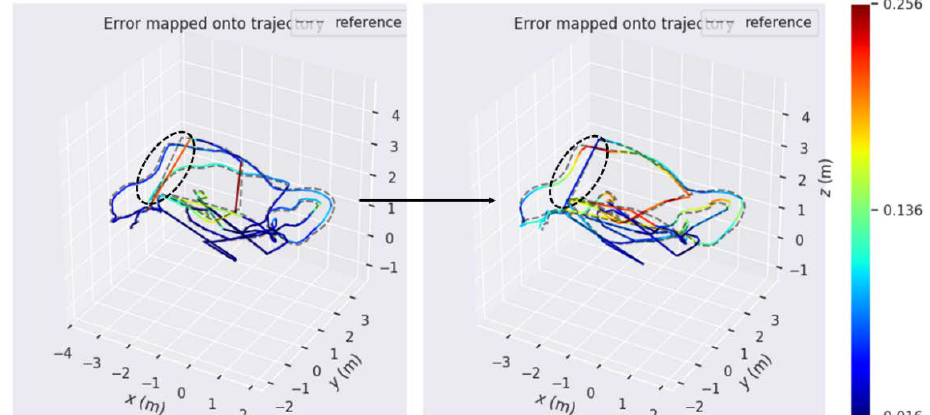
Figure 11. Comparison of the pose error trajectory of two algorithms under the sequence V2_03_difficult. The color of the trajectory changes from blue to red, and the closer the color is to red, the bigger the error. The one on the left is the posture trajectory error map based on ORB-SLAM, and the one on the right is the posture trajectory error map based on the improved PL-SLAM. Circled in black are trajectories of two algorithms corresponding to a continuous weak-texture environment in the sequence.